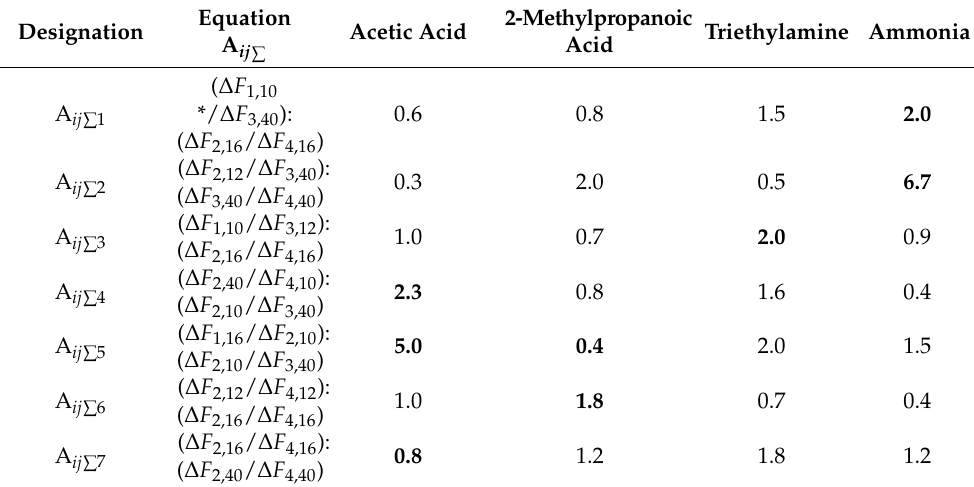
Table 11. Parameters A ij ∑ for VOCs calculated considering the kinetic features of sorption on sensors with polycomposite coatings ( n = 3, S r (0.05) < 0.15).